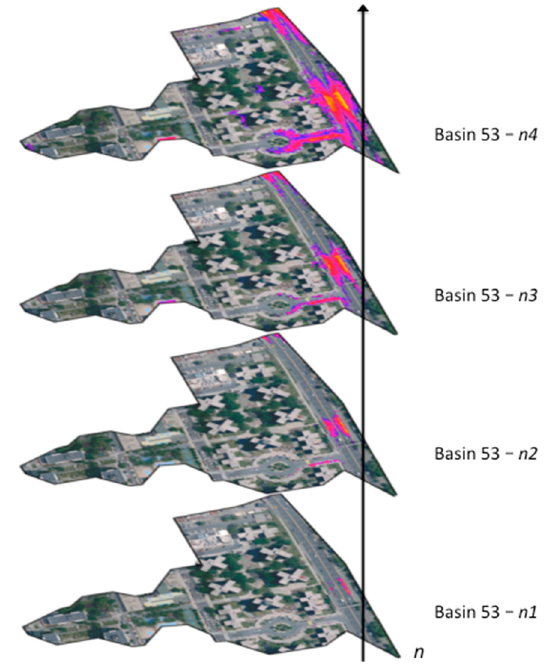
Figure 5. Flood levels for NYEPA Basin number 53 where n represents each new flood level at subsequent elevation Δ L increments.